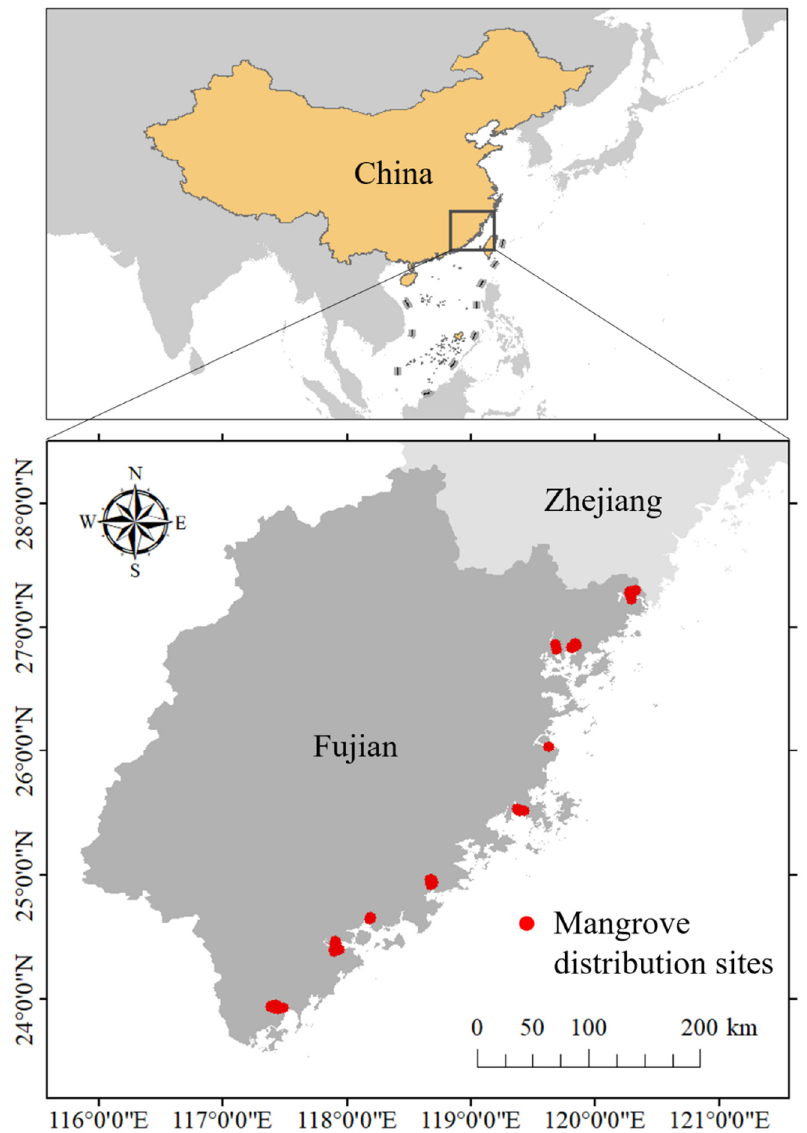
Figure 1. Study area and mangrove distribution